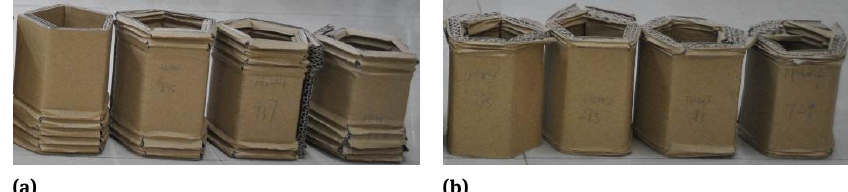
Figure 12: Influence of impact block mass on compression deformation: (a) X- and (b) Y-direction regular pentagon paper corrugation